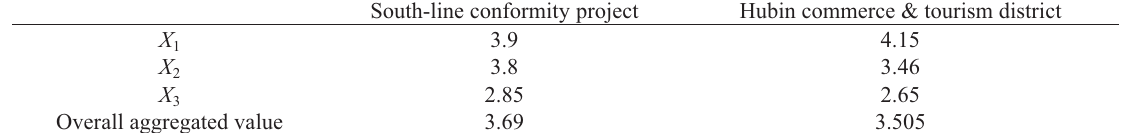
Table 10. The functions degree using